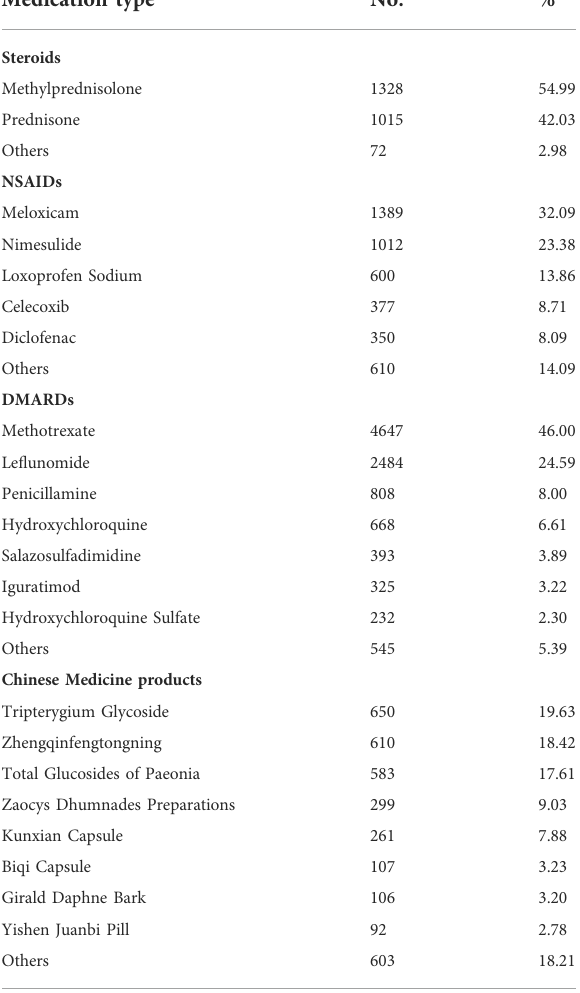
TABLE 1 Types of medications used by patients with Rheumatoid Arthritis at baseline and during follow-up. Medication